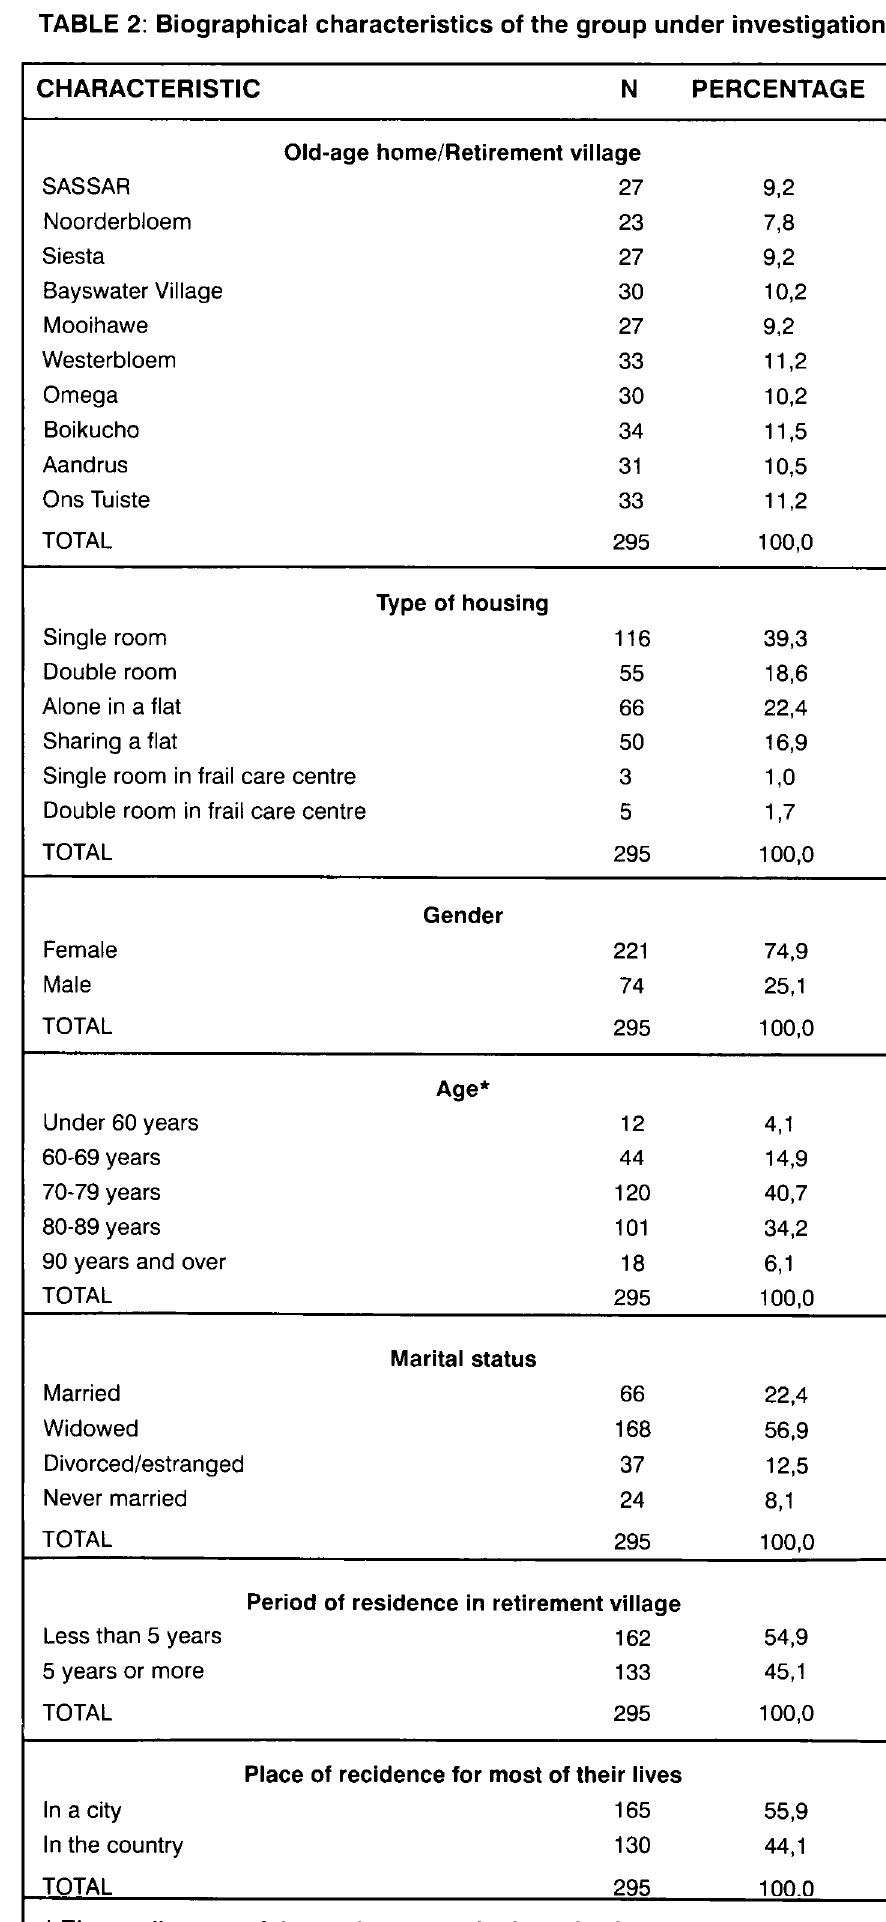
TABLE 2: Biographical characteristics of the group under investigation CHARACTERISTIC N PERCENTAGE